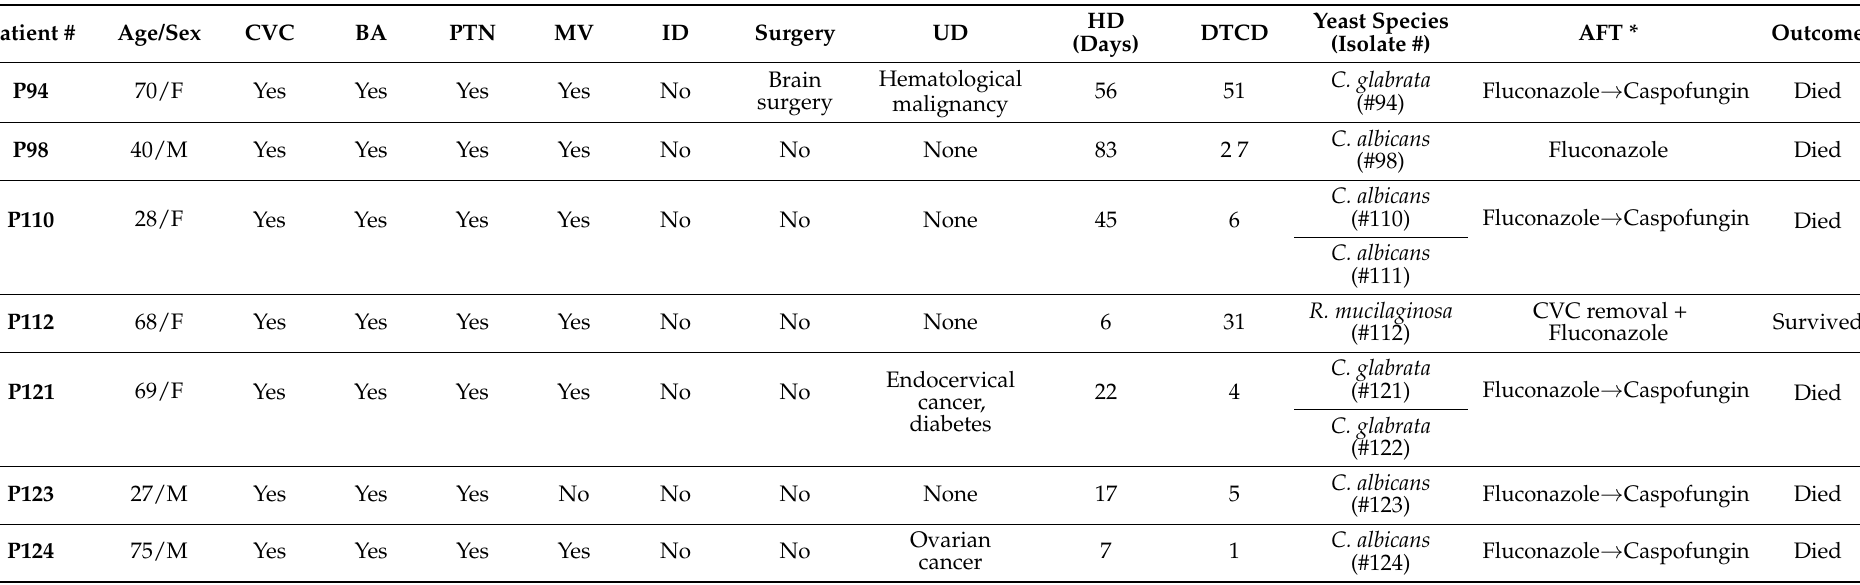
Table 1. Clinical profiles of patients with COVID-19-associated candidemia admitted to COVID-19 intensive care units of two hospitals in Mashhad, Iran, from November 2020 to late January